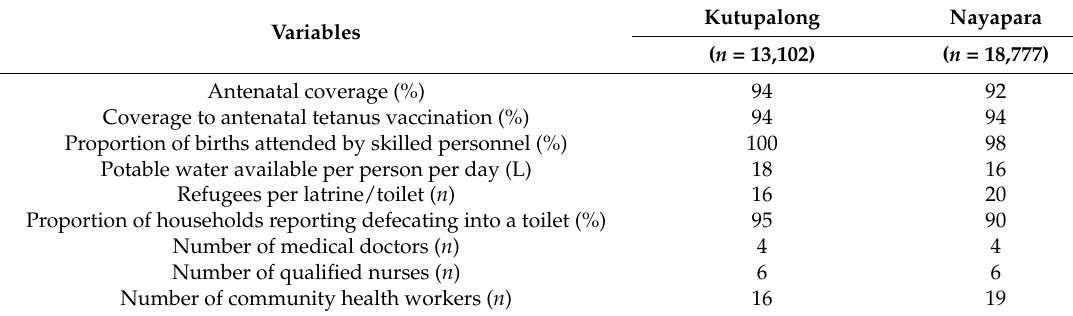
Nayapara ( n = 13,102)